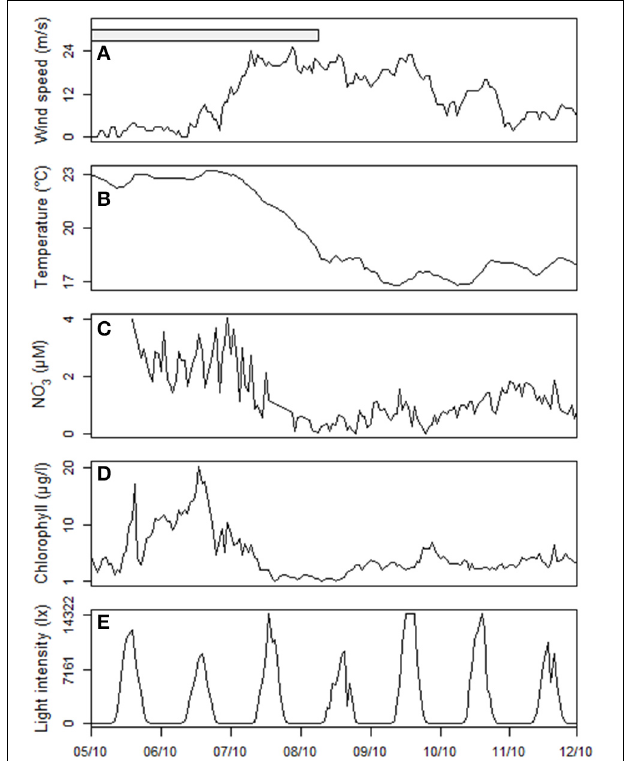
FIGURE 6 | Dynamics of the hydrological variables before, during and after the strong wind (Mistral) event. (A) Wind speed, (B) Temperature, (C) NO − 3 concentration, (D) Chlorophyll concentration, and (E) Light intensity. of clusters C1–C3, C5, and C8 (correlation coefficient 0.36,